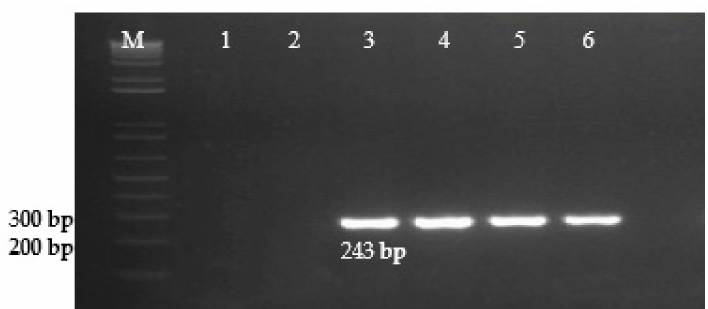
Figure 3. Detection of S. Typhimurium using PCR primers ST mdh-1F and ST mdh-1R (243 bp). Lane M—1kb ladder (Invitrogen). Lane 1—PCR products amplified from S. Enteritidis (S.e-0071), lane 2— S. Virchow (reference strain), lane 3—PCR products amplified from S. Typhimurium (S.t-0072) (positive control), lanes 4, 5, 6—clinical samples, positive for S. Typhimurium.